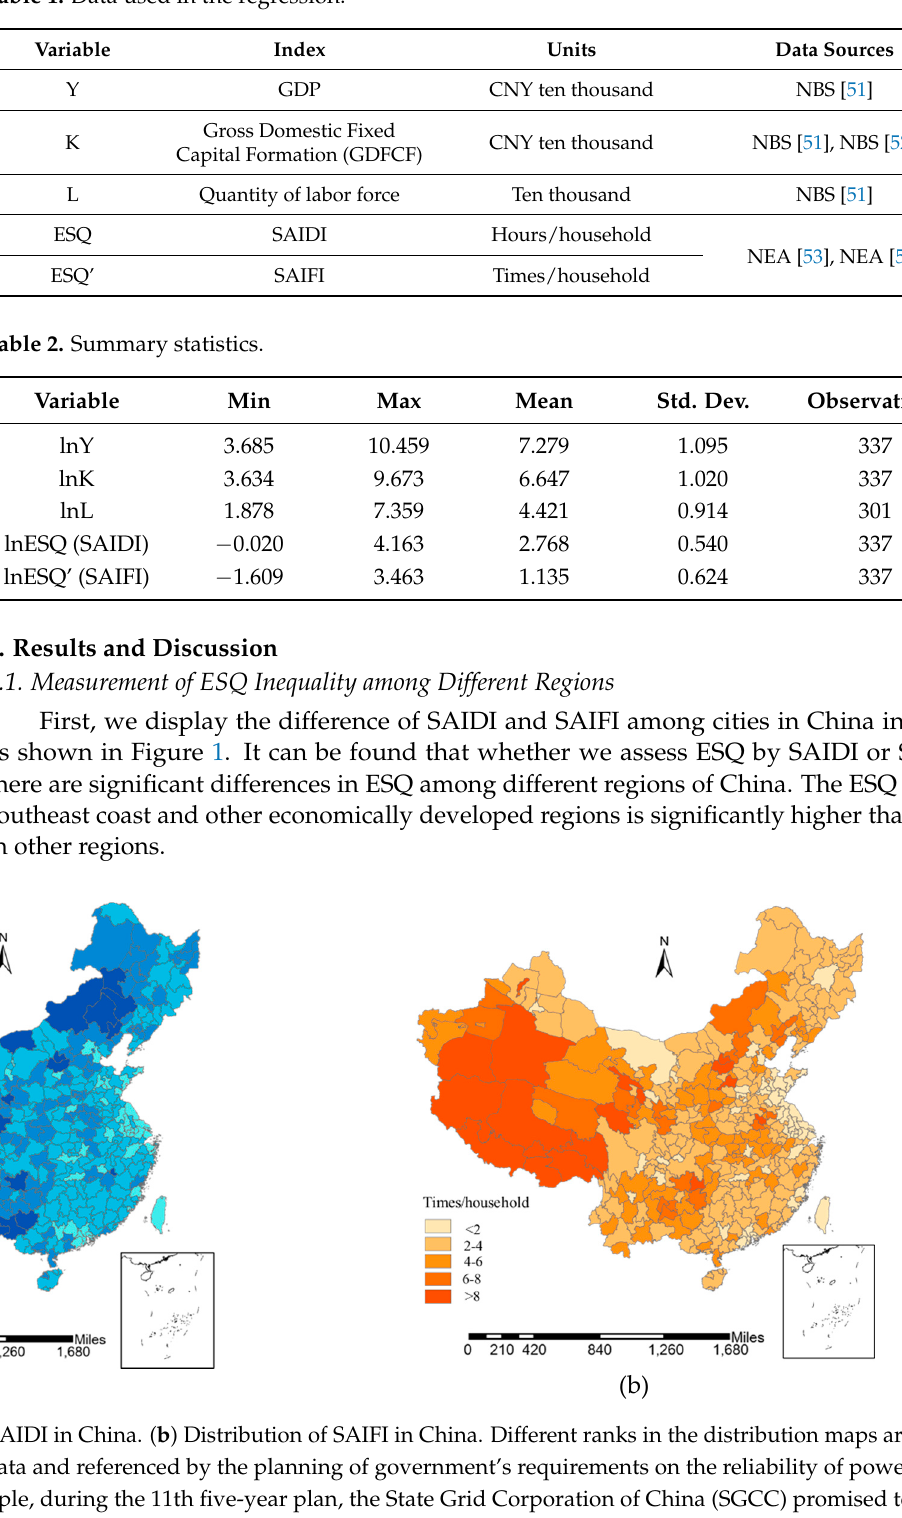
Table 1. Data used in the regression.